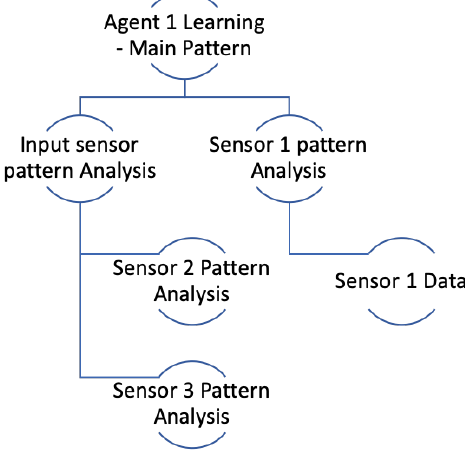
Figure 7. Learning process structure of an